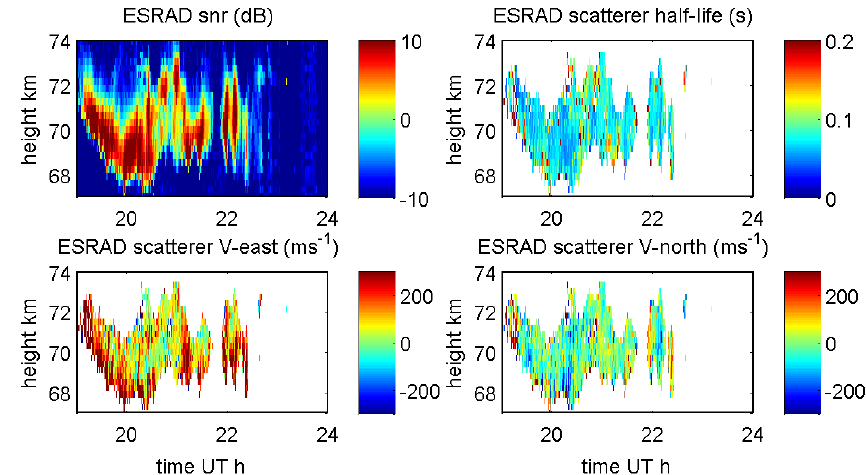
Fig. 8. Results of full correlation analysis of ESRAD data during the evening PMWE event. Top left panel shows signal-to-noise ratio, top right panel shows scatterer lifetime (time to decay to half power), bottom left panel shows eastward horizontal scatterer drift speed, bottom right panel shows northward horizontal scatterer drift speed (all 300-m height resolution, 22s average data, one profile each 64s).